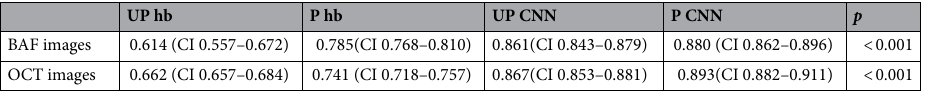
Table 3. Comparison of performances (AUROCs) of the 4 different methods on BAF images (first row) and OCT images (second row). The analysis responds to the question “which method performed better in differential diagnosis based on BAF/OCT images?”. BAF blue autofluorescence, CNN convolutional neural network, OCT optical coherence tomography, P CNN CNN classification of unprocessed images, P hb human- based classification of processed images, UP CNN CNN classification of unprocessed images, UP hb human- based classification of unprocessed images.